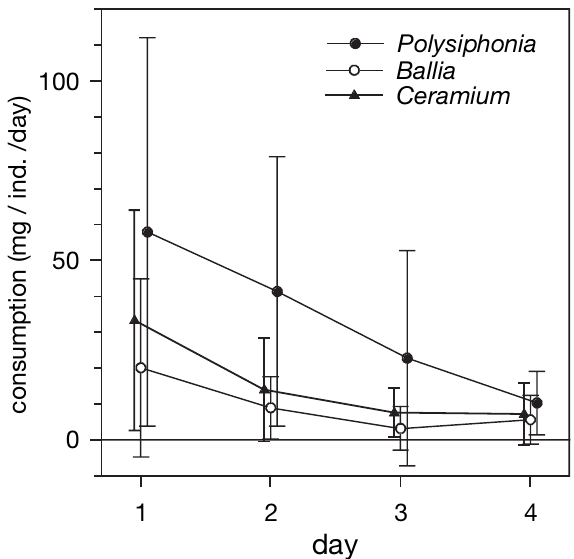
F IG . 2. – Daily average consumption rates of Munida subrugosa (n = 5) in multiple-choice experiments between three different species of red algae during the experimental period of 5 days. Vertical lines are standard